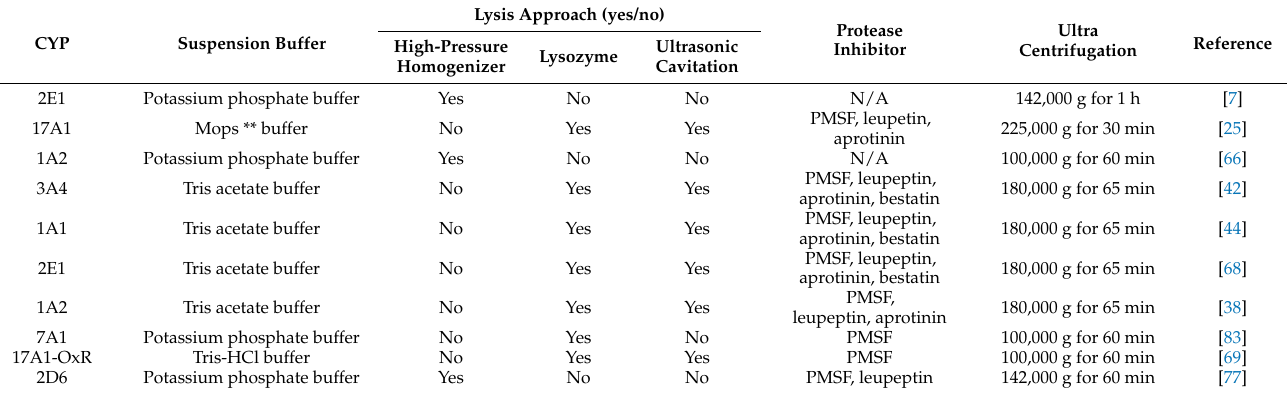
Table 2. Conditions of E. coli membrane isolations for selected human